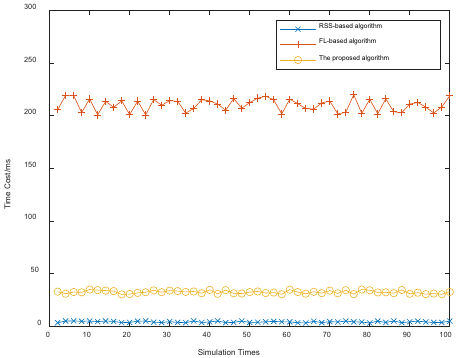
Fig. 10. Time cost versus simulation